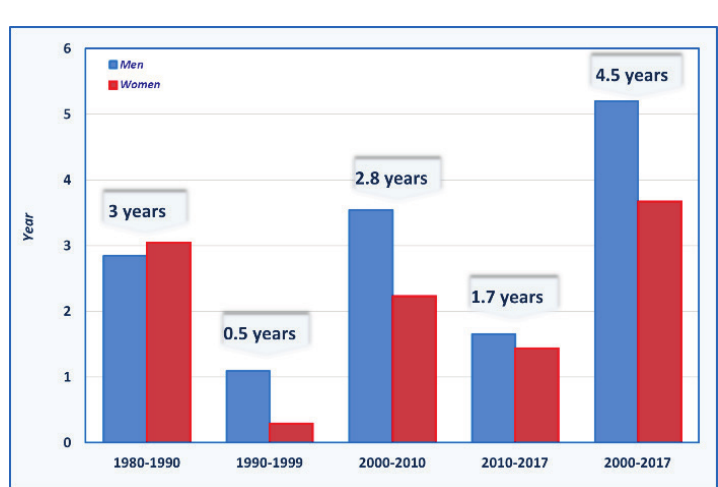
Figure 14. Increment in life expectancy at birth in Azerbaijan. Source: according to SSC and author’s calculations.